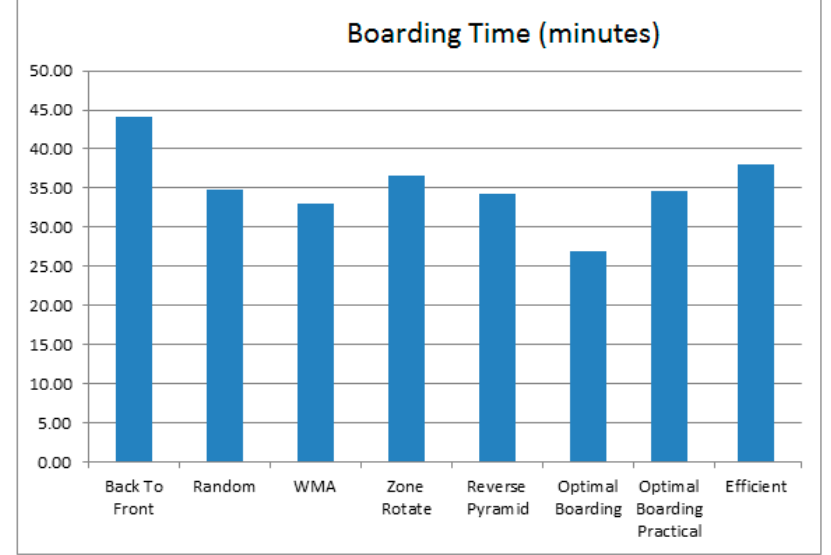
Figure 31. Boarding time with variable walking delays.